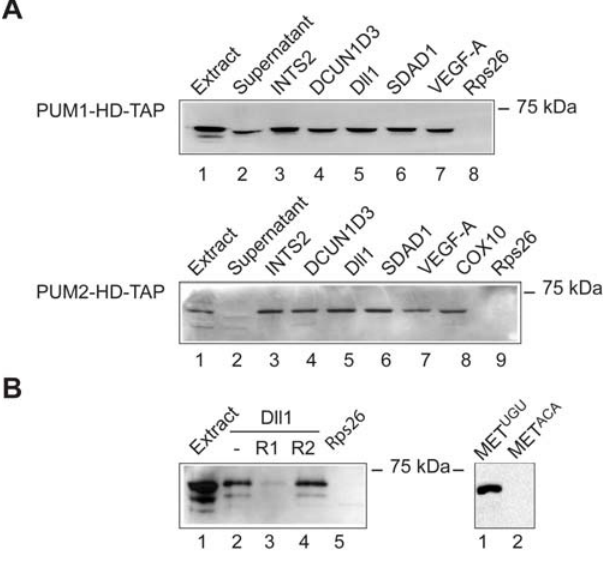
Figure 4. Validation of human PUM mRNA targets. RNA-protein complexes formed between biotinylated 3 9 -UTRs and extracts of HeLa S3 cells expressing PUM1-HD-TAP and PUM2-HD-TAP were purified on streptavidin magnetic beads and monitored for the presence of TAP- PUM-HD by immunoblot analysis with anti-PAP antibody. (A) Biotin- labeled 3 9 -UTR sequences for indicated genes (lanes 3 to 8) were incubated with PUM1-HD-TAP and PUM2-HD-TAP extracts (lane 1). Rps26 3 9 -UTR was used as negative control probe RNA (lanes 8/9). The supernatant after pull-down with INTS2 is shown in lane 2. (B) Validation of the PUF-binding motif. Biotinylated RNA corresponding to the Dll1 3 9 -UTR was combined with PUM1-HD-TAP extract (lane 2) and 100-fold excess of competitor RNA (R1; AUUGUAAAUA; lane 3) or control RNA where the core motif is mutated (R2; AUACAAAAUA; lane 4). A fragment of MET 3 9 -UTR bearing wild type (UGU) or mutant (ACA) PUF binding sites is shown in lanes 5 and 6. doi:10.1371/journal.pone.0003164.g004 PLoS ONE |